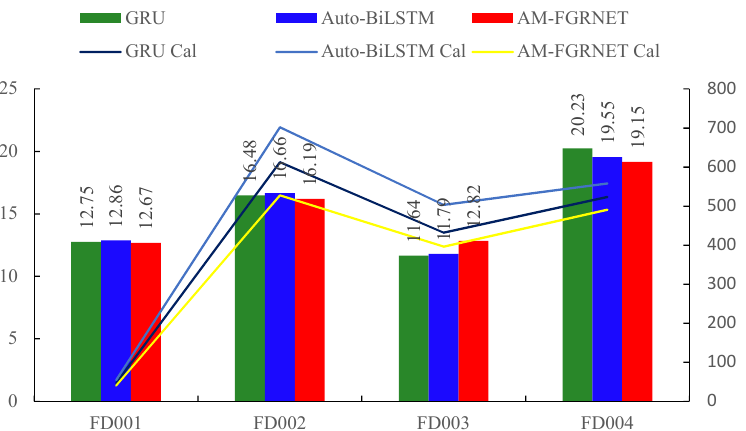
Figure 19. Comparison of predicted scores and calculation time of GRU, Auto-BiLSTM, and AM- FGRNET.